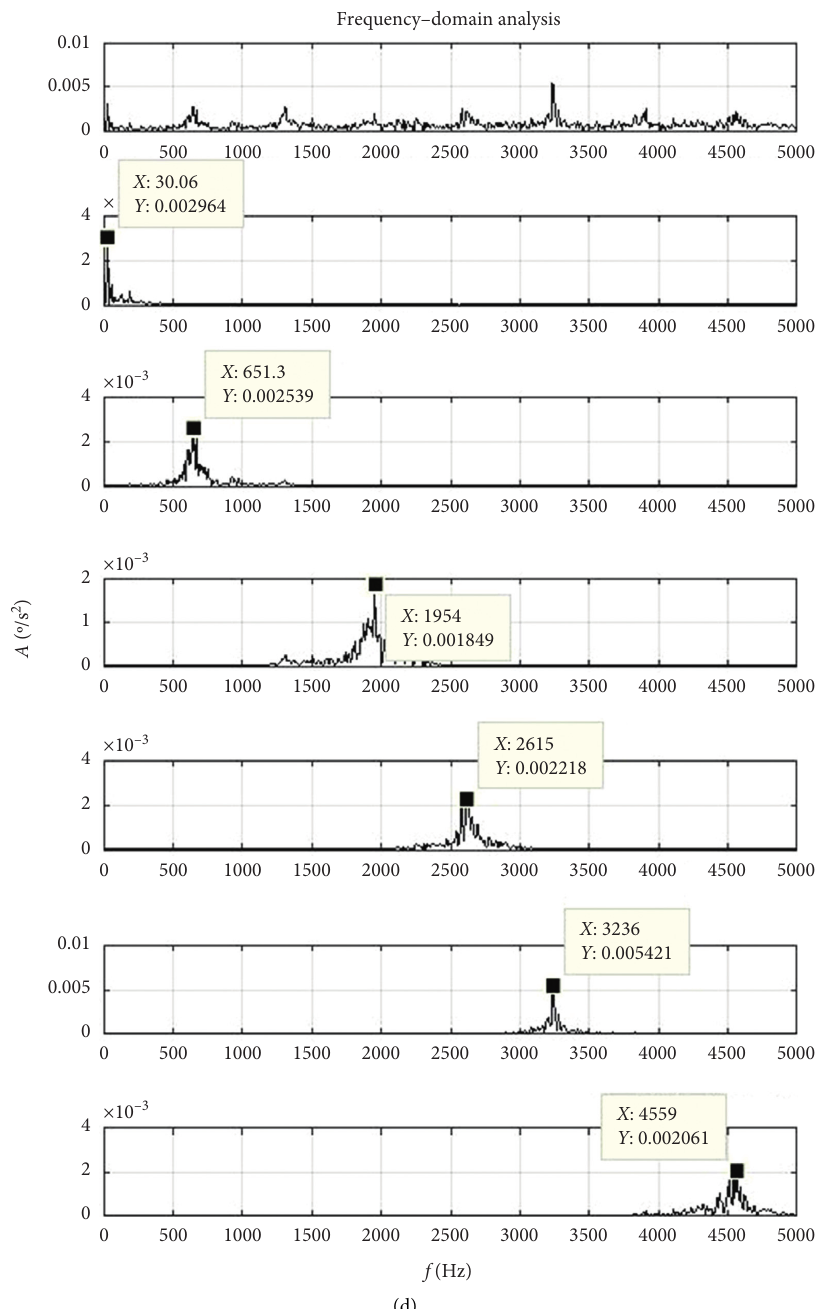
Figure 16: VMD results for no crack and three crack cases. (a) No crack. (b) 1 # crack. (c) 2 # crack. (d) 3 # crack.